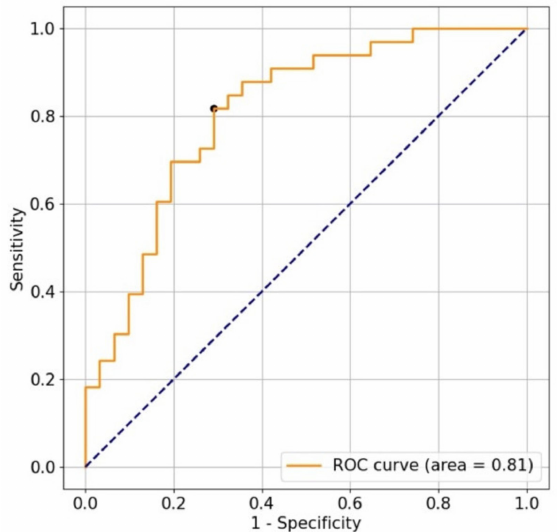
Figure 7. The receiver operating characteristic curve for classification using the jerk of the trajectory of the stylus tip. The sensitivity and specificity were 82% and 71%, respectively, when the cutoff was the black point closest to the upper left of the graph. The area under the curve was